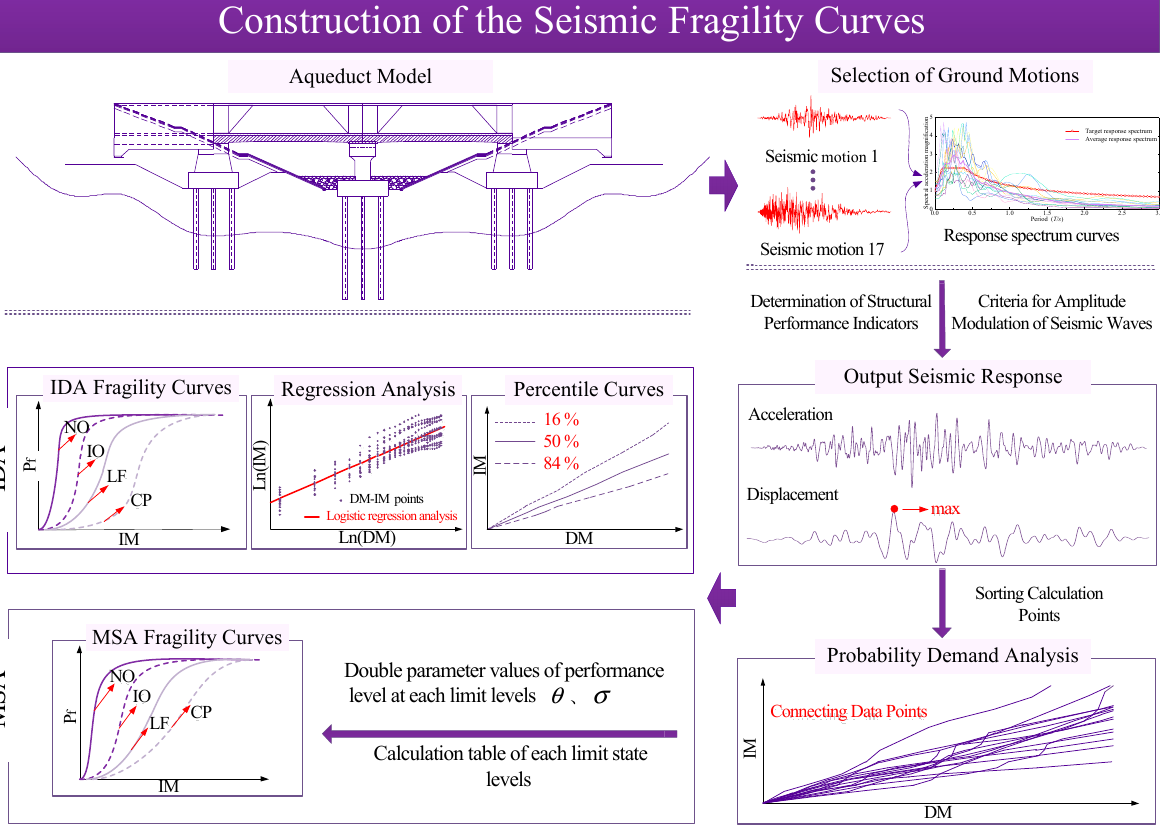
Figure 6. Illustration of the steps for generating fragility curves.